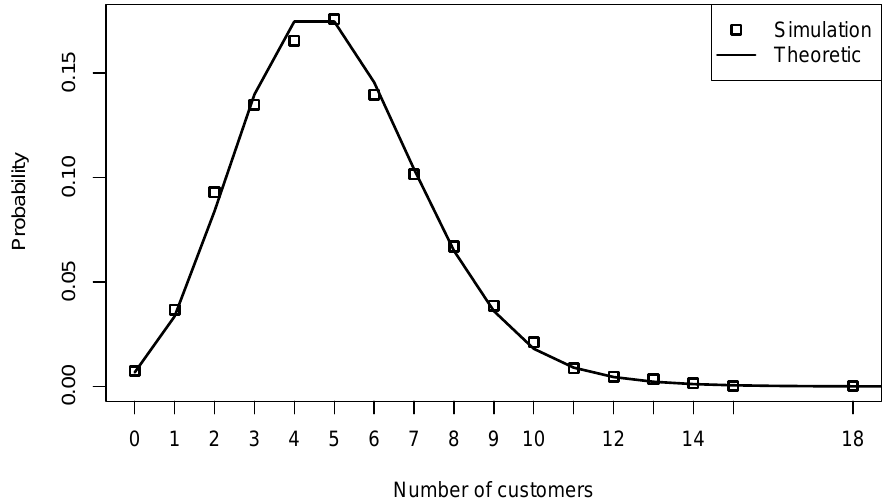
Figure 2. Theoretical distribution of the steady-state queue size in an M / M /10 system vs.empirical distribution ( N = 5000 samples), with input rate λ = 7.5, service rate µ = 1.5. The uniform distance between the theoretical and estimated queue size distributions equals ∆ =